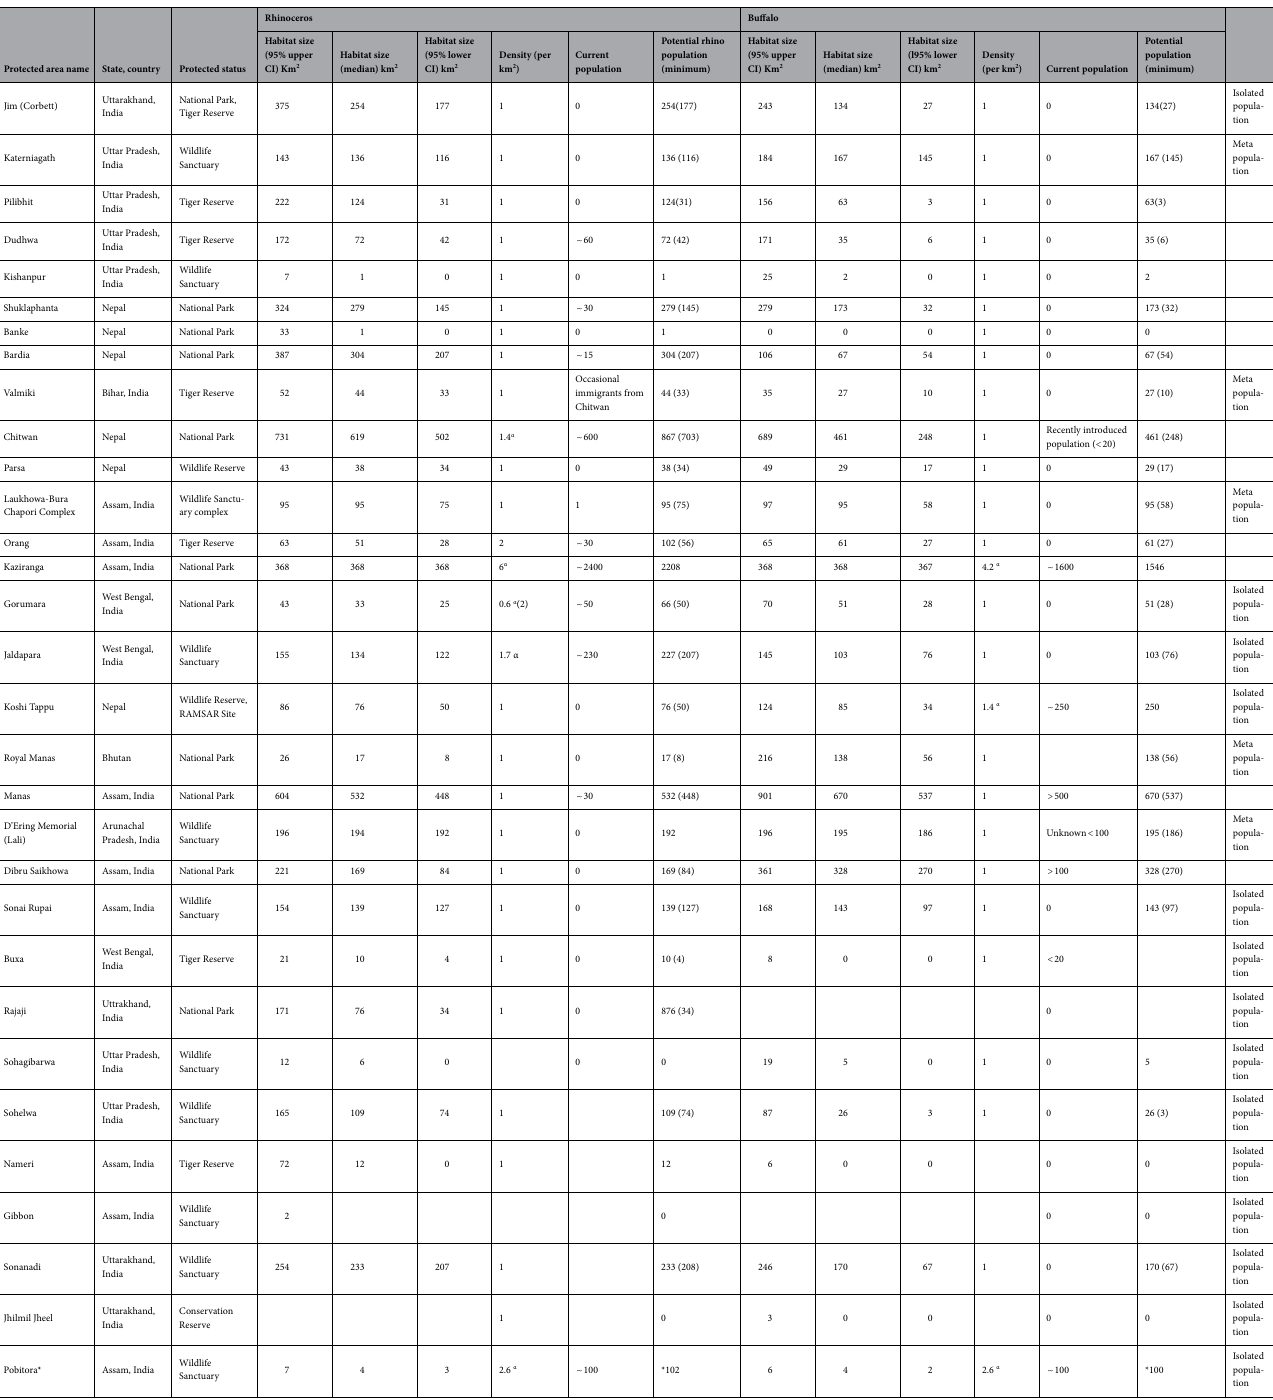
Table 4. Suitable habitats for rhinoceros and buffalo, their legal status, current/potential population that each site can sustain and possibility of metapopulation structure. *Pobitora has extant population of ~ 100 Greater one-horned Rhinoceros and ~ 100 Buffalos. α Actual know crude density at extant